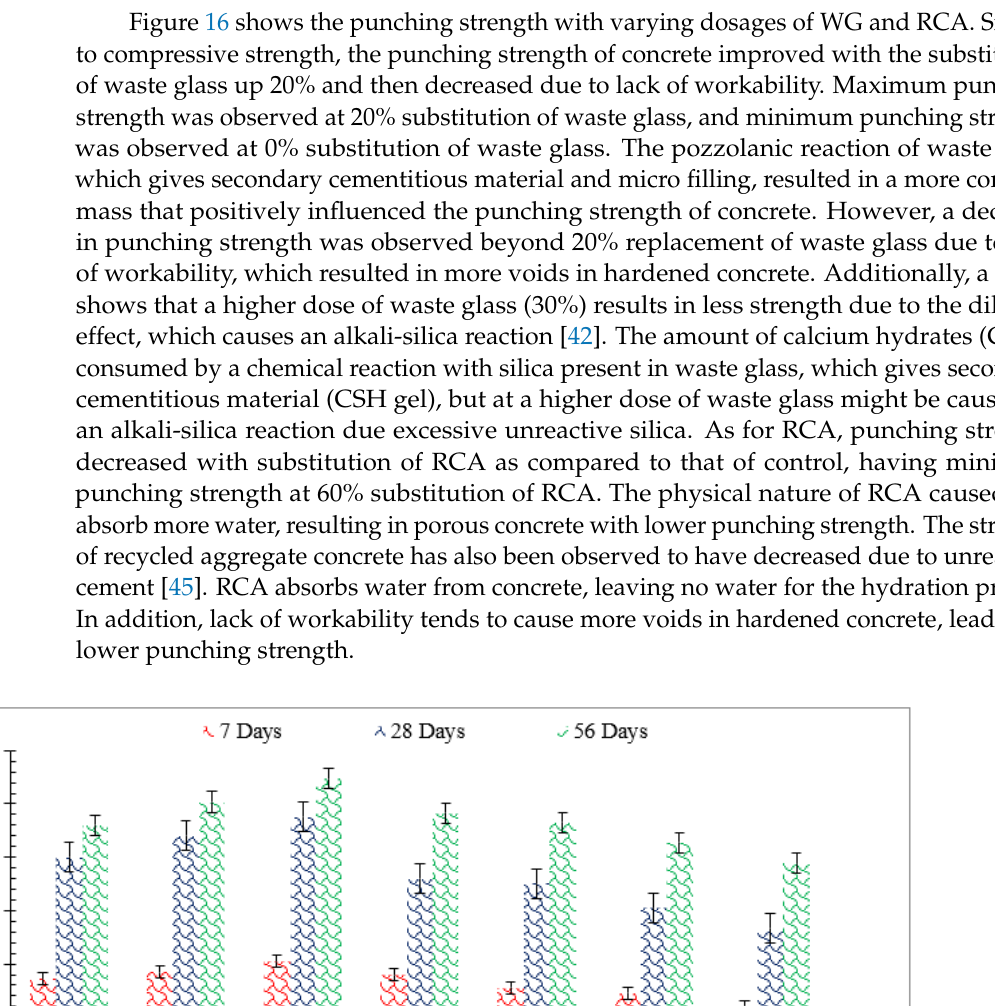
Figure 17. Relative punching strength. Response surface and contour plot for punching strength after 28 days of curing are shown in Figures 18 and 19, respectively. It can be observed from the contour plot that RCA decreased punching strength while WG increased punching strength.